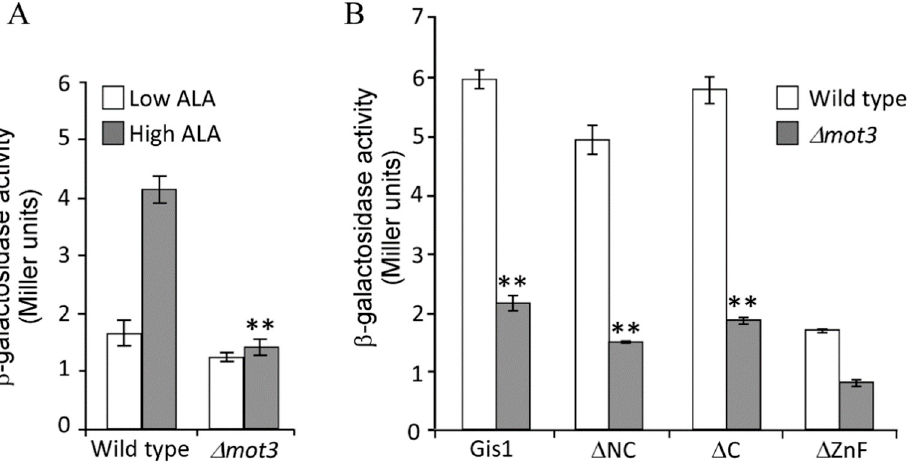
Figure 7. Mot3 is required for heme activation of Gis1 transcriptional activity in vivo. ( A ) Deletion of the MOT3 gene reduces Gis1 transcriptional activity in heme-sufficient cells. Wild type Δ hem1 (WT) or Δ mot3 Δ hem1 ( Δ mot3) cells bearing the PDS- lacZ reporter and expressing Gis1 were grown at a low (2.5 μ g/mL) or high levels (250 μ g/mL) of ALA. β -galactosidase activities (mean+SD) were measured from at least three independent cultures. For statistical analysis, the activities in wild type cells were compared to those in Δ mot3 cells at the same heme levels with a Welch 2-sample t-test. ** p value, 0.0001. ( B ) Deletion of the Gis1 JmjN/C domain does not abolish the requirement of Mot3 for heme activation. β -galactosidase activities (mean + SD) were measured from at least three independent